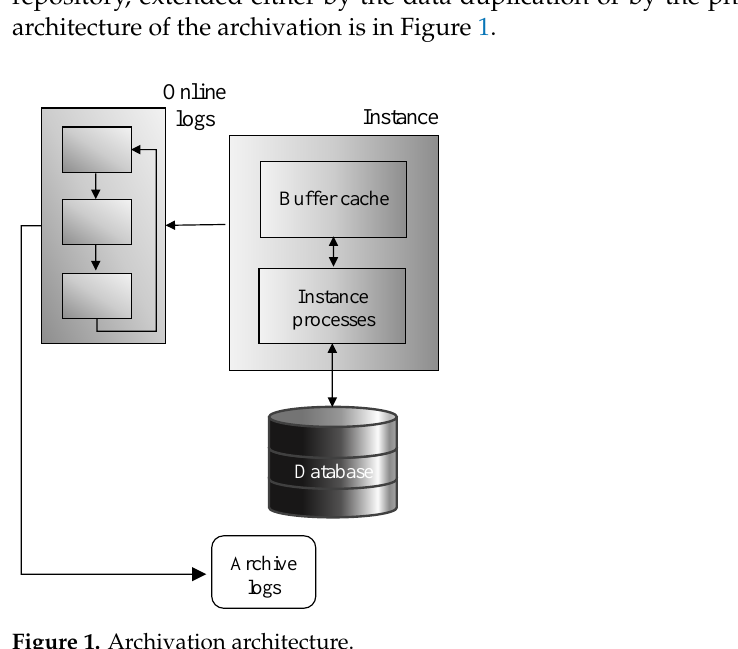
Figure 1. Archivation architecture.